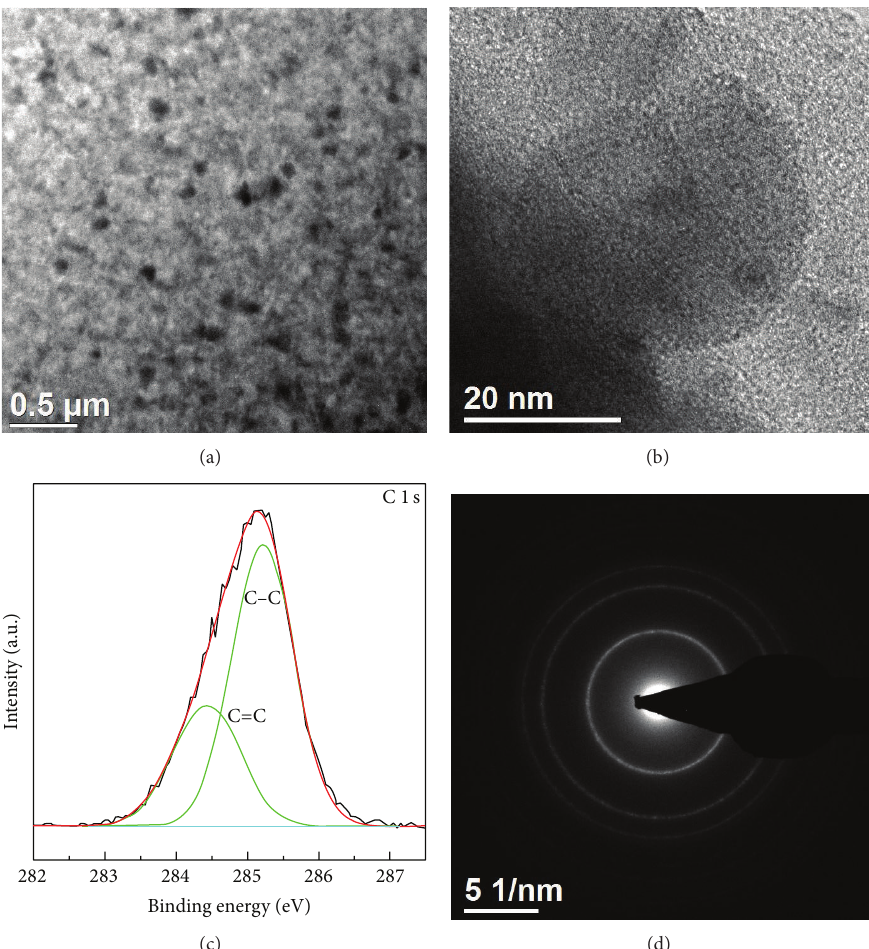
Figure 4: (a) Bright field TEM, (b) HR-TEM, and (c) XPS spectra for the diamond film grown at 40 Torr and (d) the corresponding SAED pattern,